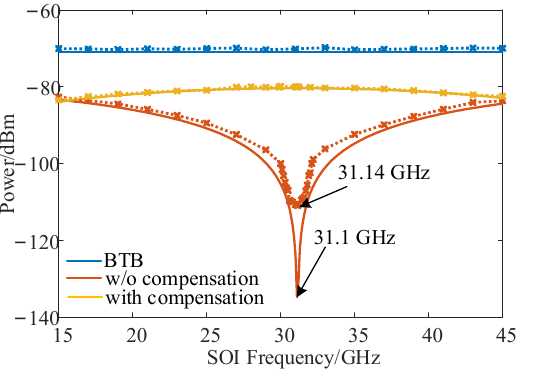
Figure 7. Measured IF power as a function of the SOI frequency in the theoretical analysis (solid line) and in the simulation (dashed line).